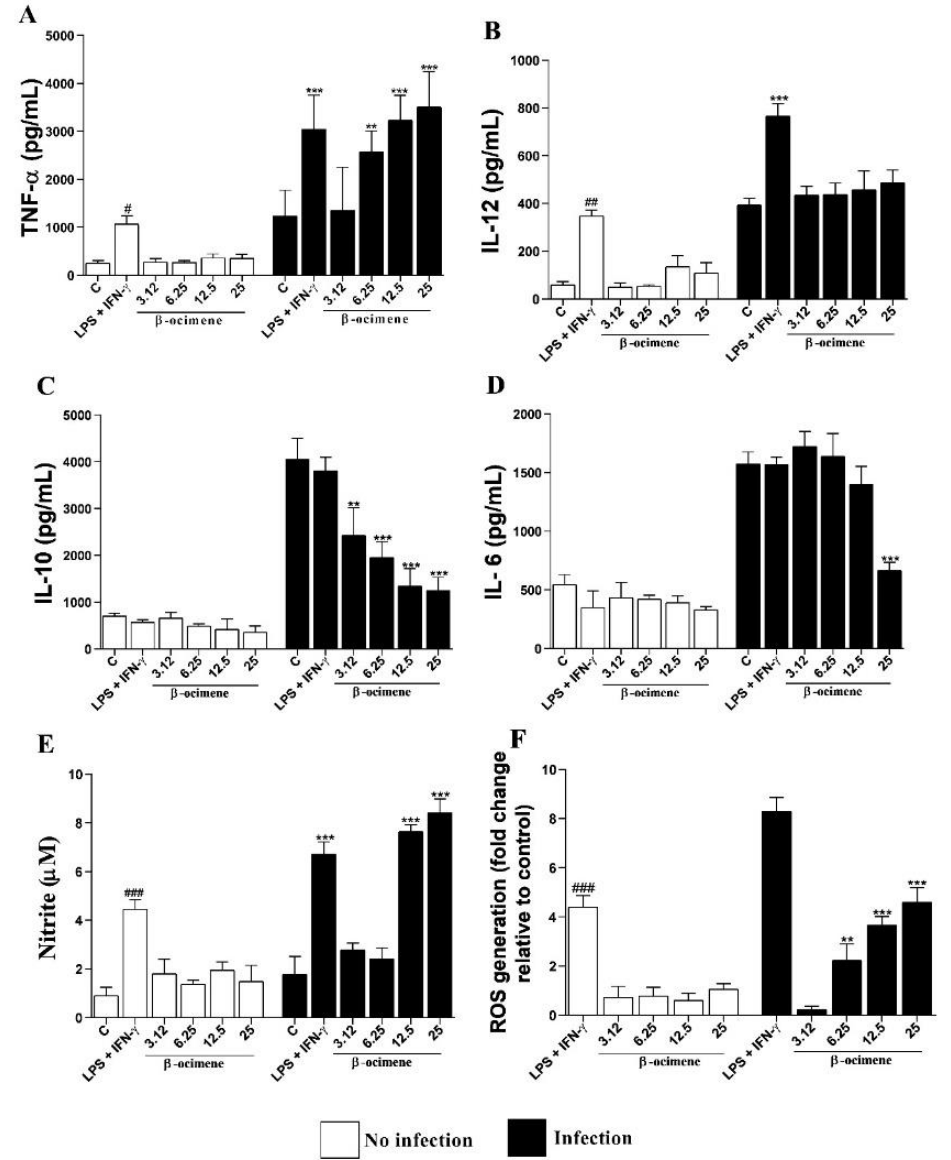
Figure 4. Levels of TNF- α ( A ), IL-12 ( B ), IL-10 ( C ), IL-6 ( D ) cytokines, and NO ( E ) and ROS ( F ) produced by RAW 264.7 macrophages uninfected and infected with Leishmania amazonensis and treated with β -ocimene for 72 h at 37 °C and 5% CO 2 . The results represent means ± standard error for three independent experiments carried out in triplicate. (#) p < 0.05 vs. uninfected control; (##) p < 0.01 vs. uninfected control; (###) p < 0.001 vs. uninfected control; (**) p < 0.01 vs. infected control; (***) p < 0.001 vs. infected control. C—control. LPS—lipopolysaccharide. Macrophage activation parameters were evaluated based on the retention of neu- tral red and zymosan by macrophages treated with β -ocimene yet not stimulated by L. amazonensis. As shown in Figure 5A, β -ocimene promoted an increase in the volume of lysosomal vesicles at concentrations of 12.5 and 25 µ M. On the other hand, no increase in phagocytosis of zymosan particles was observed with β -ocimene treatment under the test conditions (Figure